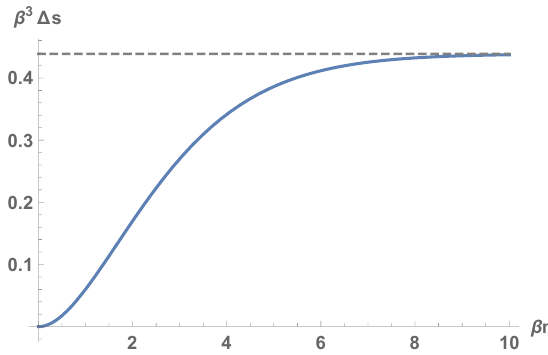
Figure 3 . The dimensionless change in the entropy density ∆ s/T 3 (solid blue) of a real scalar field thermal plasma across the nucleated bubble as a function of the scalar mass m/T . Since the scalar p mass m = λ/ 2 φ 0 ( x ) increases across the bubble as the scalar condensate increases, the entropy in the broken phase decreases. The maximum amount by which the entropy density can change is 2 π 2 T 3 / 45 , which is formally reached when m → ∞ , when the entropy density inside the bubble tends to zero (horizontal dashed).